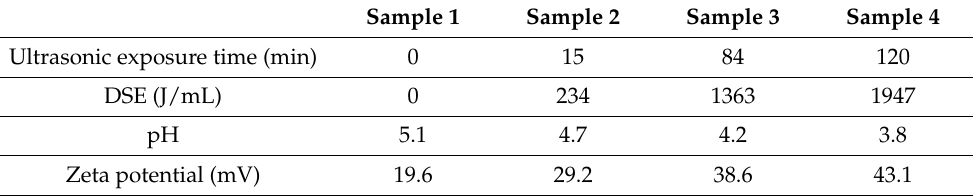
Table 3. Changes in DSE, pH, and zeta potential with increasing ultrasonic exposure